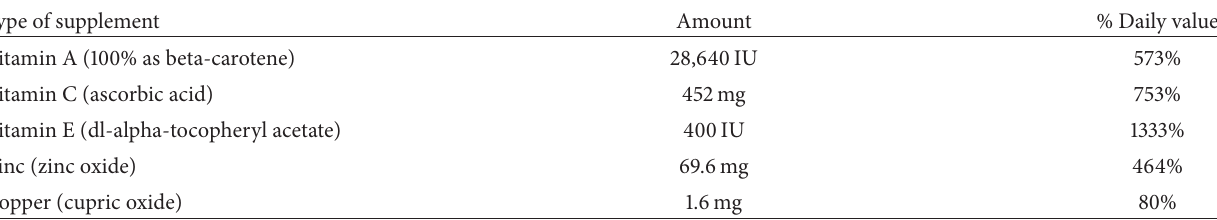
Table 1: AREDS formula daily dose (4